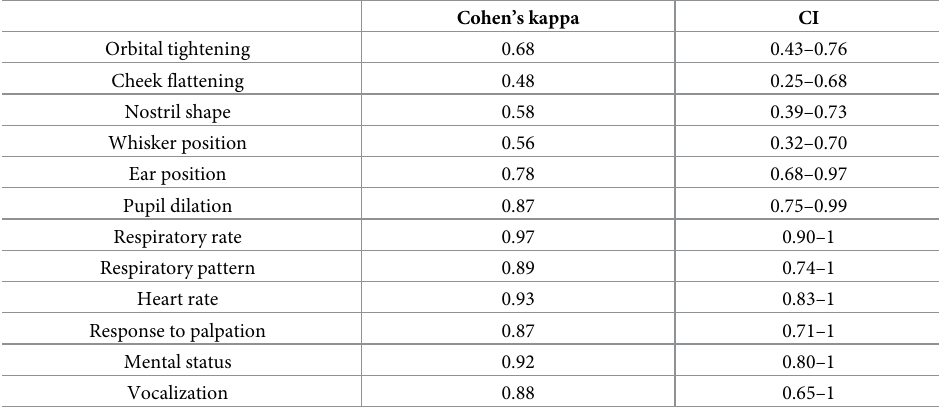
Table 4. Cohen’s kappa results between veterinarians and students for each parameter.